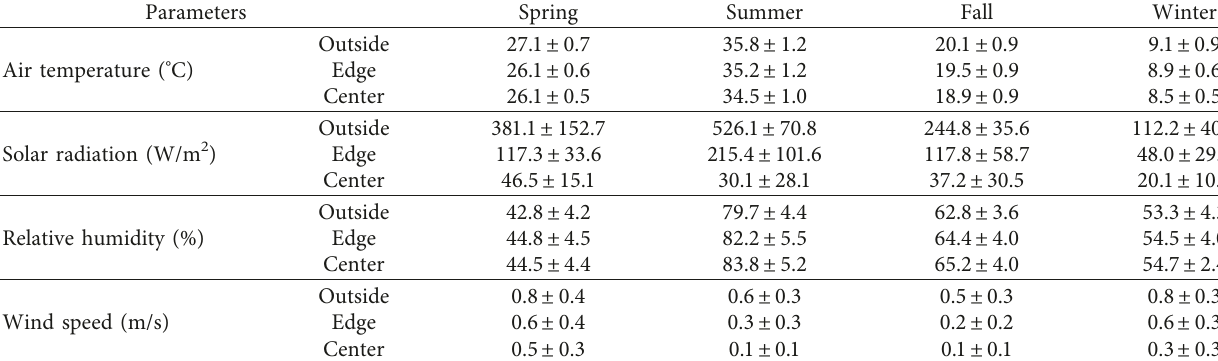
Table 3: Average seasonal values of the micrometeorology parameters.